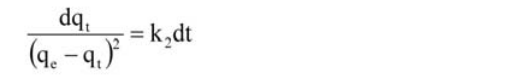
=45 mg/L, 0.1 g/100 ml (dry mass per volume), 23 °C, i